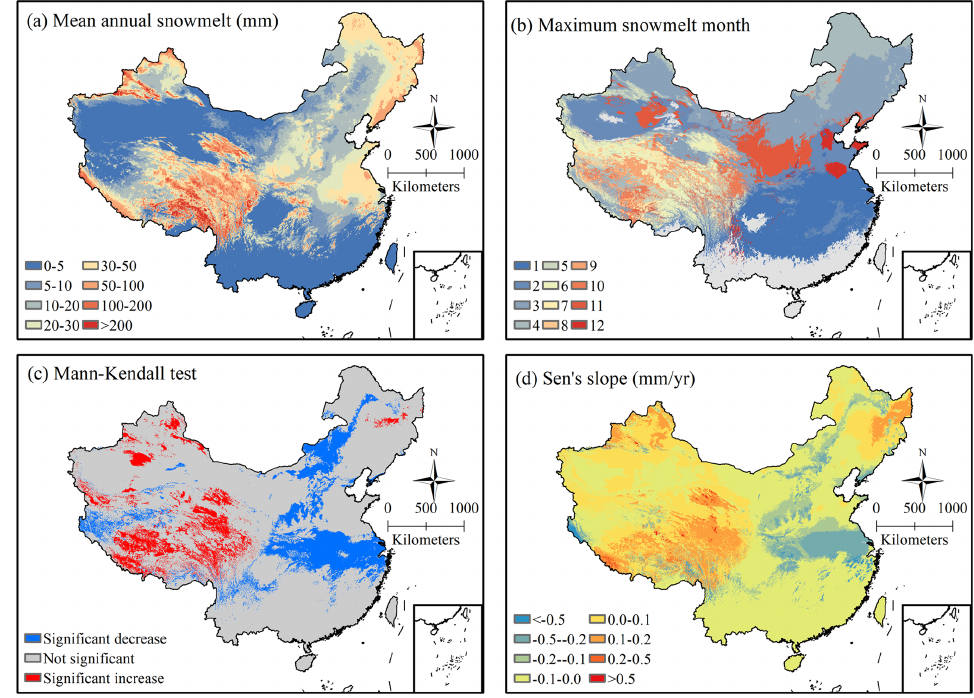
Figure 7. Spatial distribution of mean annual snowmelt (a) , the month of maximum snowmelt (b) , trends in annual snowmelt based on the Mann–Kendall method (c) and Sen’s slope of the annual snowmelt in China during the 1951–2017